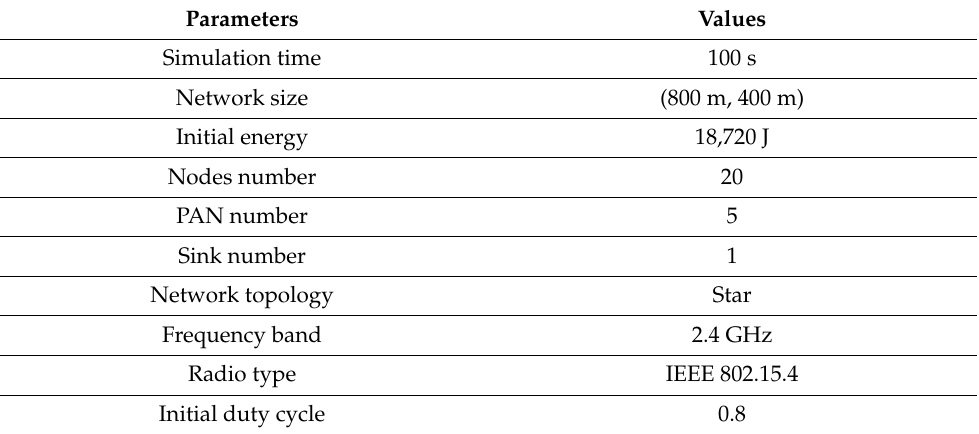
Table 1. Simulation